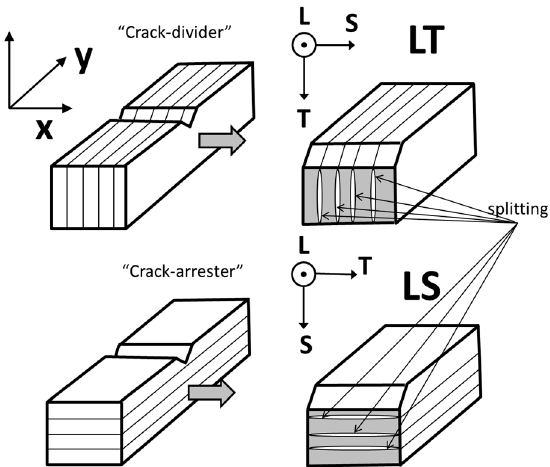
Figure 6. Schematic illustration showing laminate splitting geometries found in LT and LS samples tested, according with Cartesian x,y,z and L,T,S (Figure 1a) reference systems. (After Kimura and co-workers [28]).